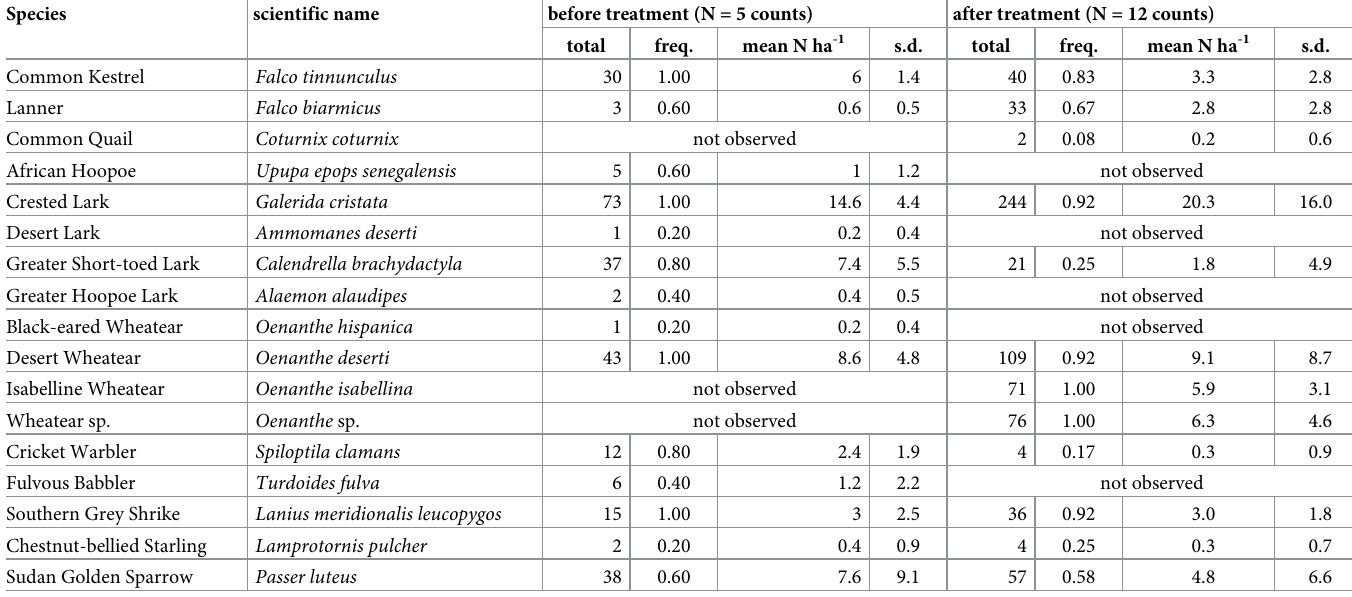
Table 3. Total number, frequency and mean ± s.d. of the most common acridivorous birds observed along the transects.